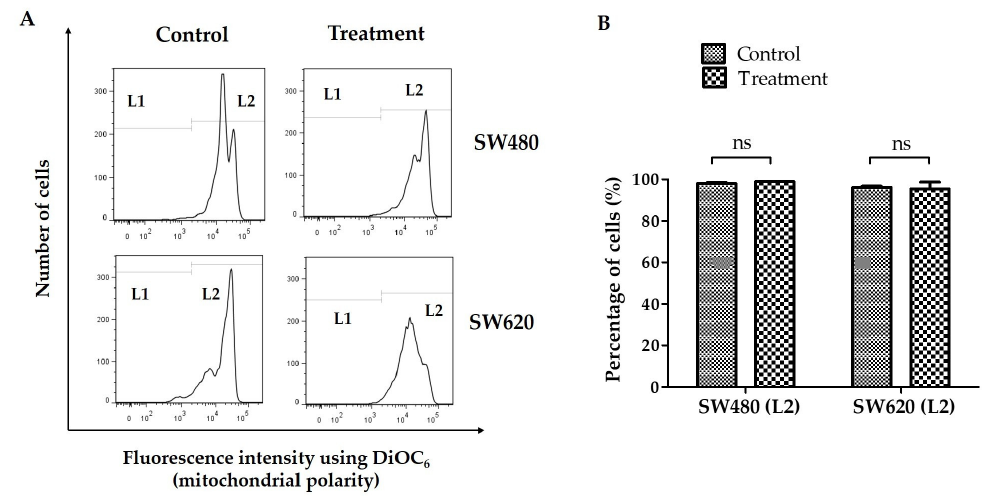
Figure 2. Effect of LMPE on mitochondrial membrane potential change ( ΔΨ 𝑚 ) in SW480 and SW620 cell lines. Histograms represent fluorescence intensity using DiOC 6 (detected by flow cytometry) in SW480 and SW620 ( A ) cells. The cells with the permeability of the mitochondrial membrane are located at L1 and the cells with polarized mitochondria are at L2. Percentage of SW480 and SW620 cells with the polarized mitochondrial membrane ( B ). Cells were exposed to 30 mg LMPE/mL for 48 h. Untreated cells (0 mg LMPE/mL) were used as a control. Data were expressed as mean ± SEM ( n = 3). The differences between the control and treated cells were analyzed with Student’s t test, ns = non-significant difference, p = 0.2368 (SW480), and p = 0.8514 (SW620).